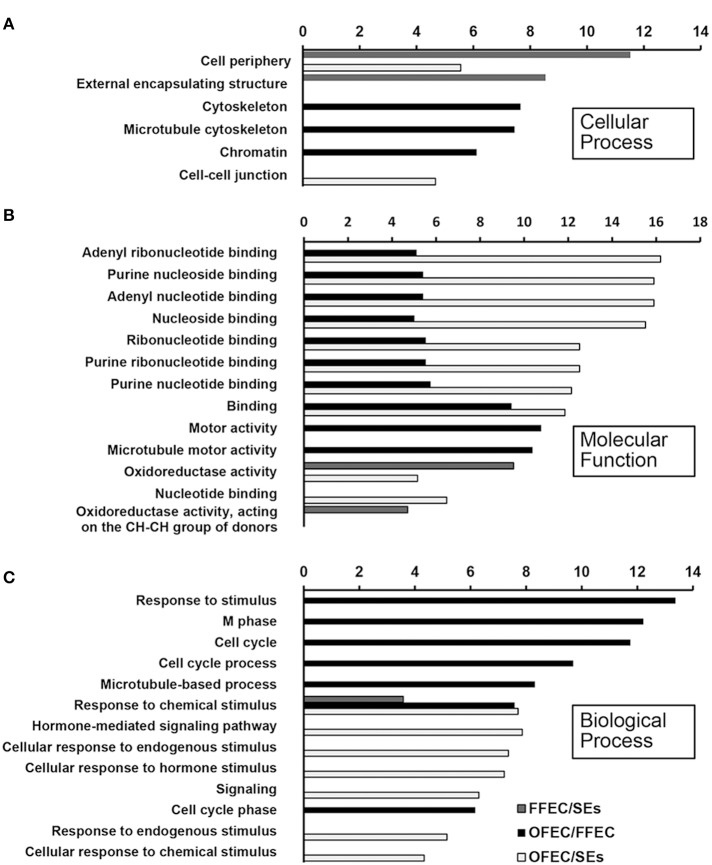
Significantly enriched GO terms of “cellular process” (A), “molecular function” (B), and “biological process” (C) by comparing SEs, FFEC, and OFEC (P ≤ 0.05). The “y” axis represented enriched GO terms among three samples. The “x” axis represented the P-value (−log2
P).